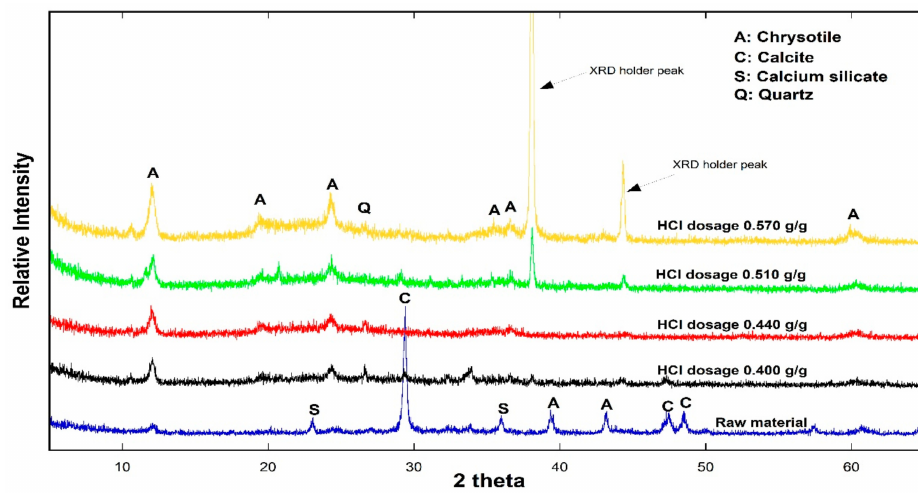
Figure 6. XRD results of solid samples obtained from cement hydrate removal tests at different HCl to solid ratio (peaks at 39 and 44 represent specimen